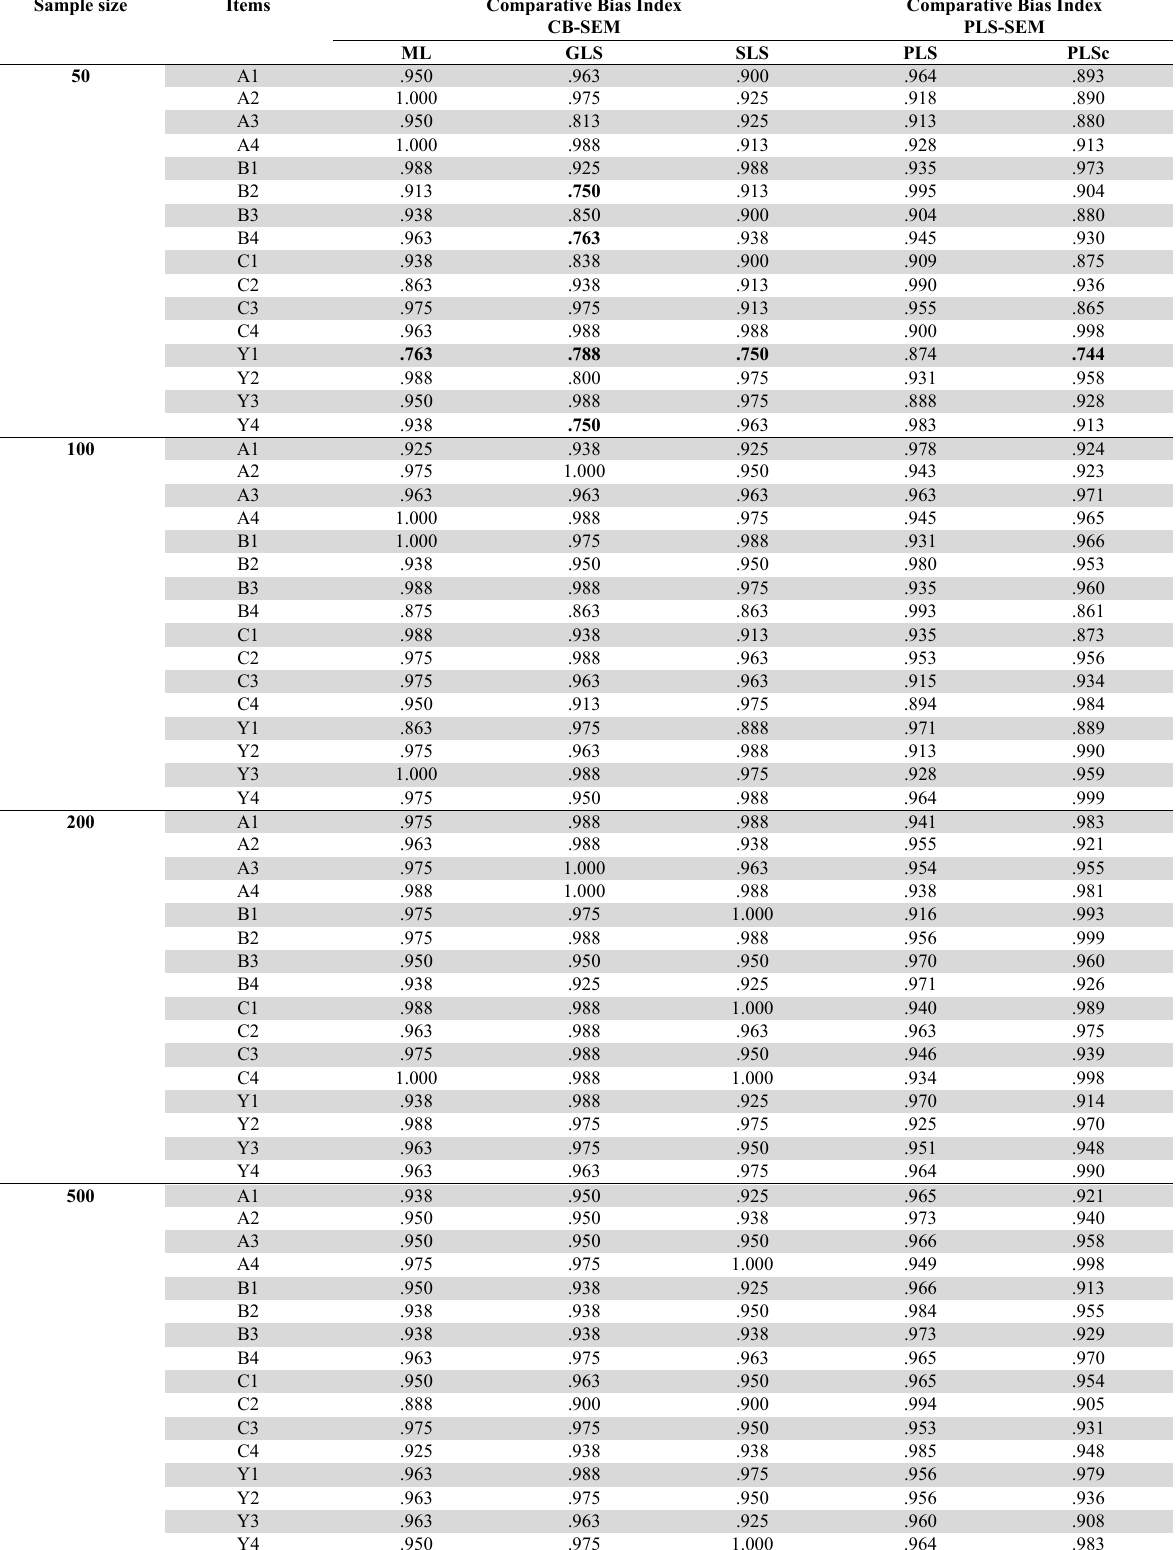
Note: Values in bold indicate unacceptable bias